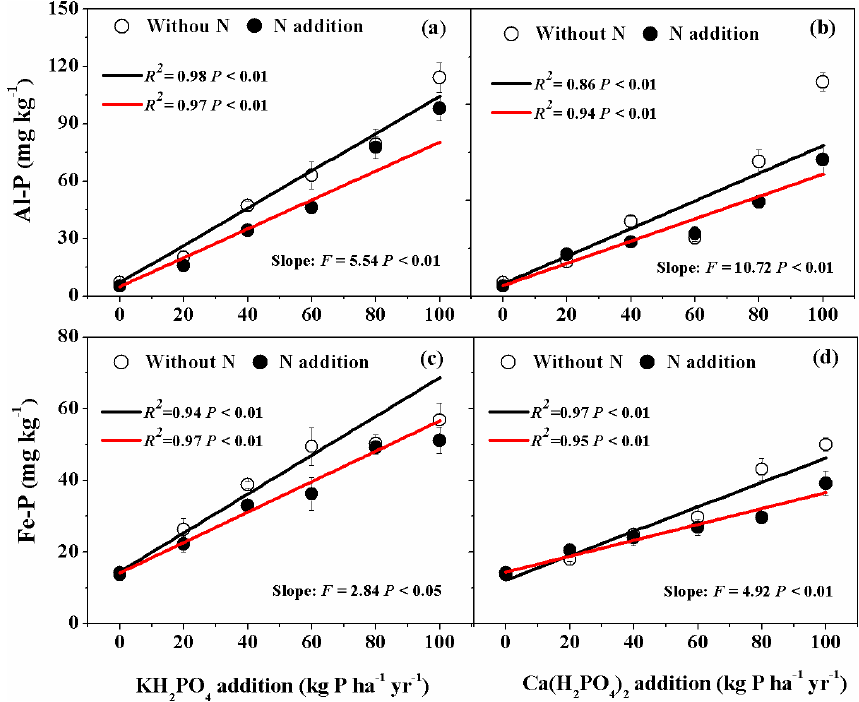
Figure 2. Effects of phosphorus (P) and nitrogen (N) additions on soil variscite (Al-P) and strengite (Fe-P). Data are represented as mean ± standard error. Phosphorus types include KH 2 PO 4 and Ca ( H 2 PO 4 ) 2 at rates of 0, 20, 40, 60, 80 and 100kgPha − 1 yr − 1 . Fitted lines are based on linear regression models. The black and red lines represent without N and N addition, respectively. Significance is labeled for slopes of the black and red